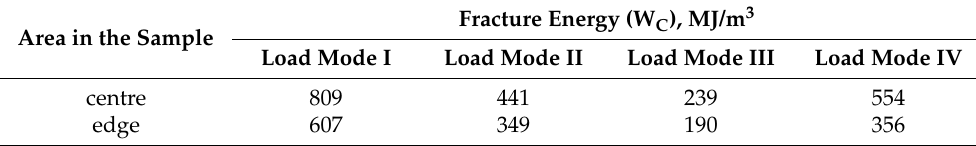
Table 1. The value of the fracture energy in the centre and surface of the sample for the 4 load modes. Area in the